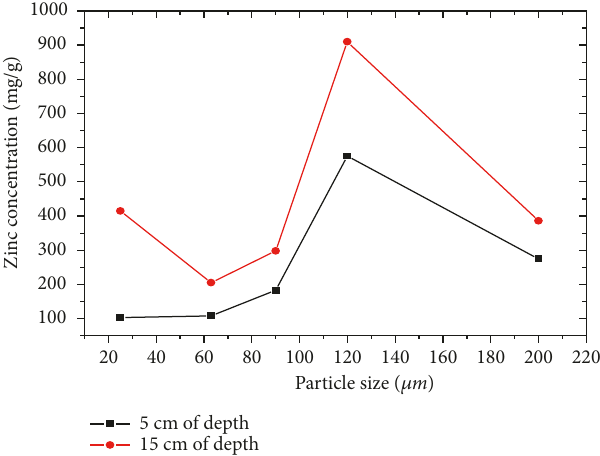
Figure 10: Evolution of zinc concentration as a function of particle size and